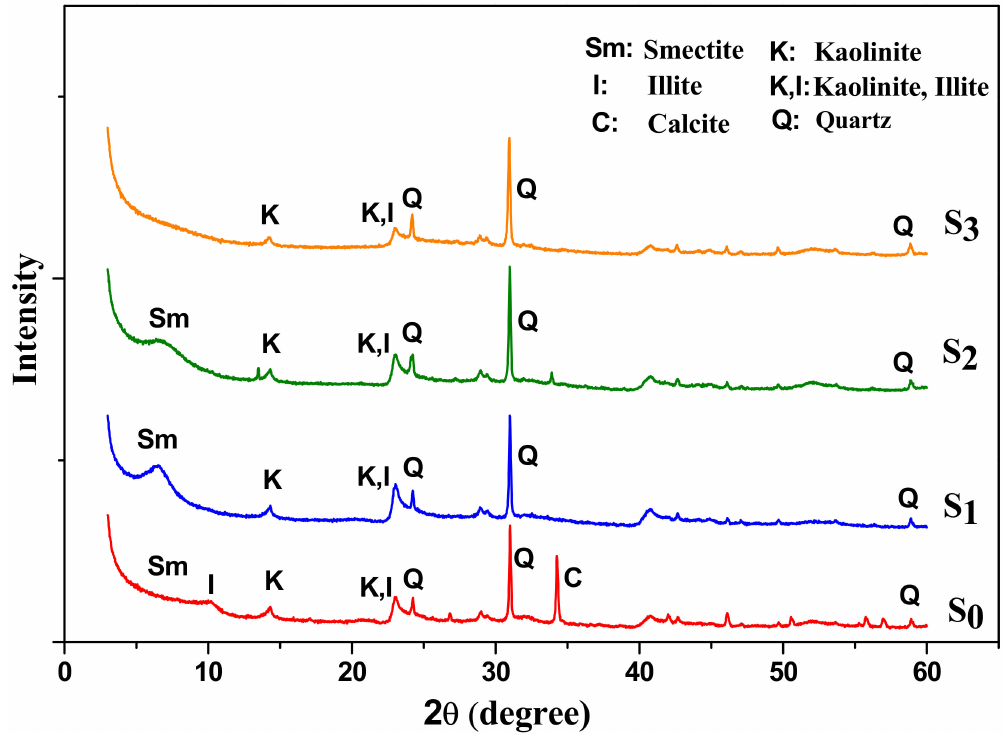
Figure 6. XRD patterns of raw material ( S 0 ) and acid-activated clay samples ( S 1 , S 2 , S 3